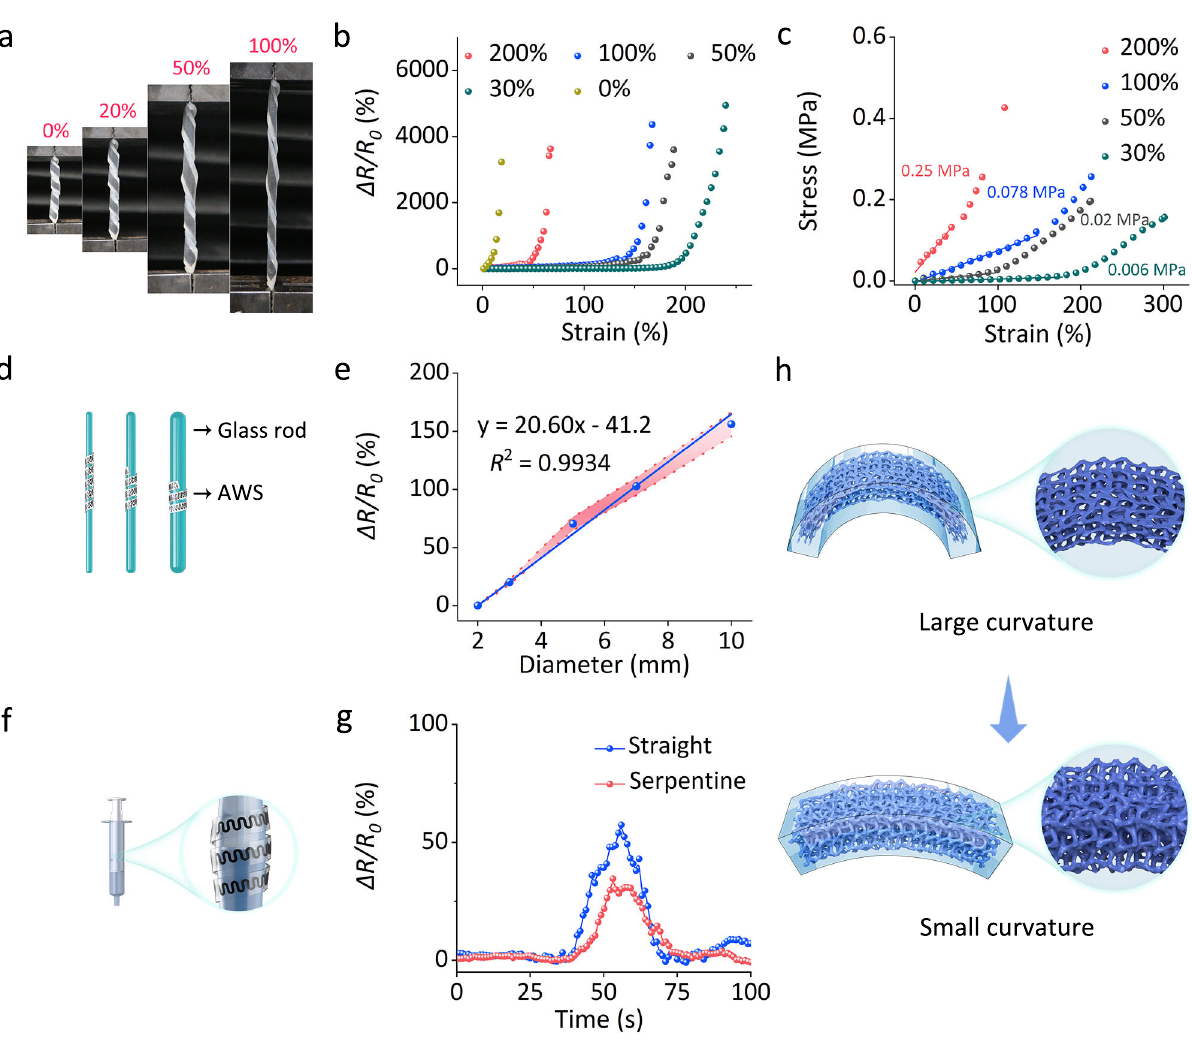
Fig. 4 Electromechanical performance. a The optical images of the experimental setup. b The relative resistance variation of AWS sensors with different prestrains versus the tensile strain. c The elastic modulus ( E ) of helical structure with different prestrains. d Schematic illustration of static simulation using glass rods. e The sensor ’ s responses to glass rods with different diameters (2, 3, 5, 7 and 10 mm). f Schematic illustration of dynamic simulation using injection syringe. g The sensor ’ s responses with dynamic simulation. h The schematic illustration of sensing